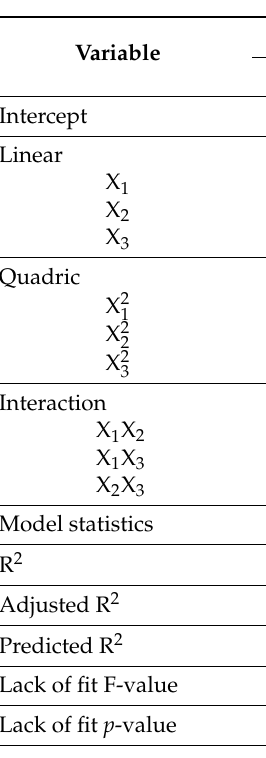
Table 5. Findings of regression